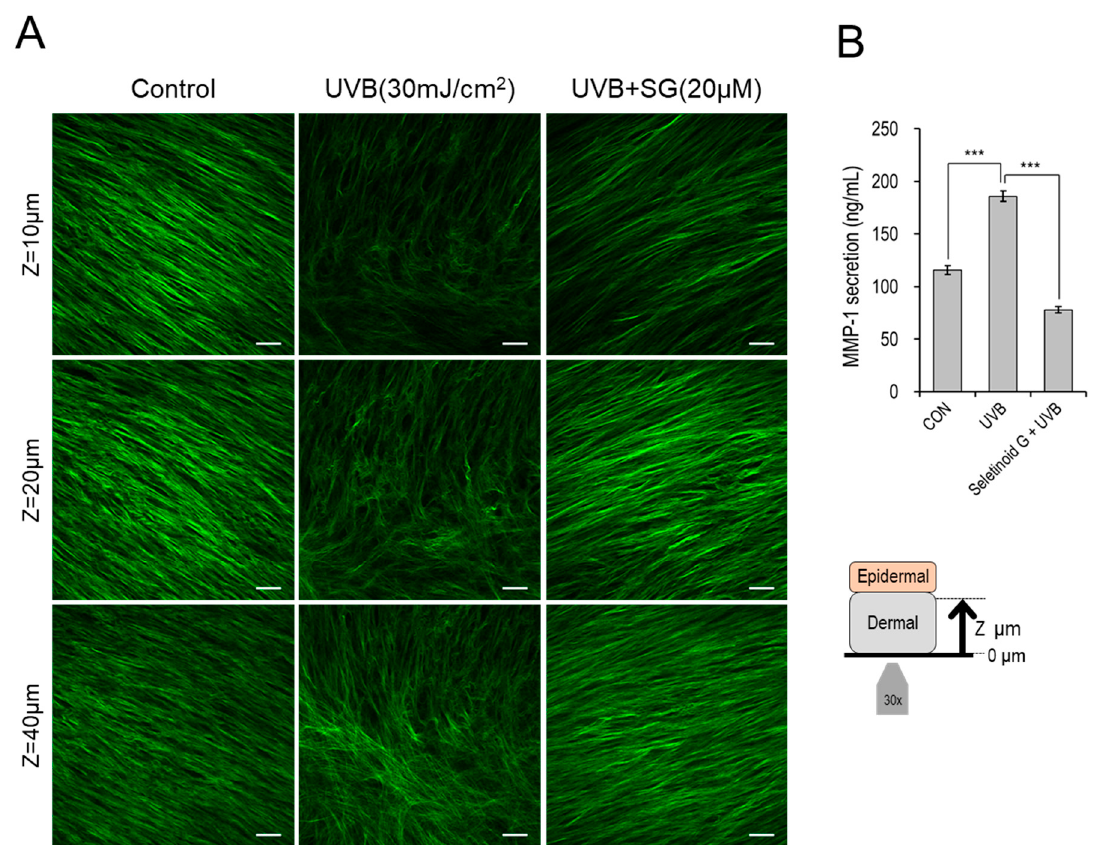
Figure 5. ( A ) Label-free multi-photon images of collagen fibrils (green) at di ff erent z-depths of the dermis in human skin equivalents (EFT-400) that were irradiated with UVB (30 mJ / cm 2 ), irradiated and treated with SG (20 µ M) in the culture medium for 48 h, or left non-irradiated and untreated (control). Scale bars indicate 40 µ m. ( B ) ELISA of matrix metalloproteinase (MMP)-1 secreted to the culture medium of human skin equivalents ( n = 3 per group). (***; p < 0.001).